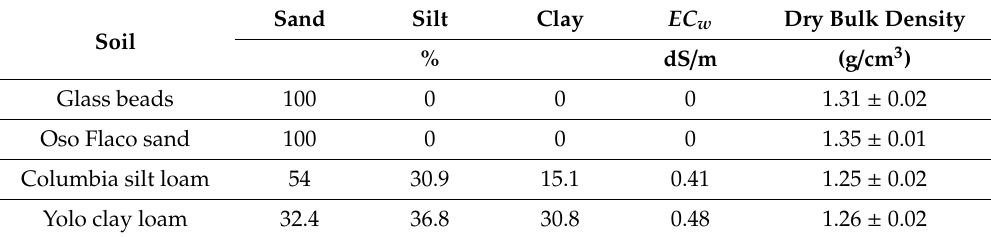
Table 1. Soil texture and e ff ect of solution electrical conductivity ( EC w ) of soils used in calibration. Sand Silt Clay EC w Dry Bulk Density Soil % dS / m (g / cm 3 ) Glass beads 100 0 0 0 1.31 ± 0.02 Oso Flaco sand 100 0 0 0 1.35 ± 0.01 Columbia silt loam 54 30.9 15.1 0.41 1.25 ± 0.02 Yolo clay loam 32.4 1.26 ±